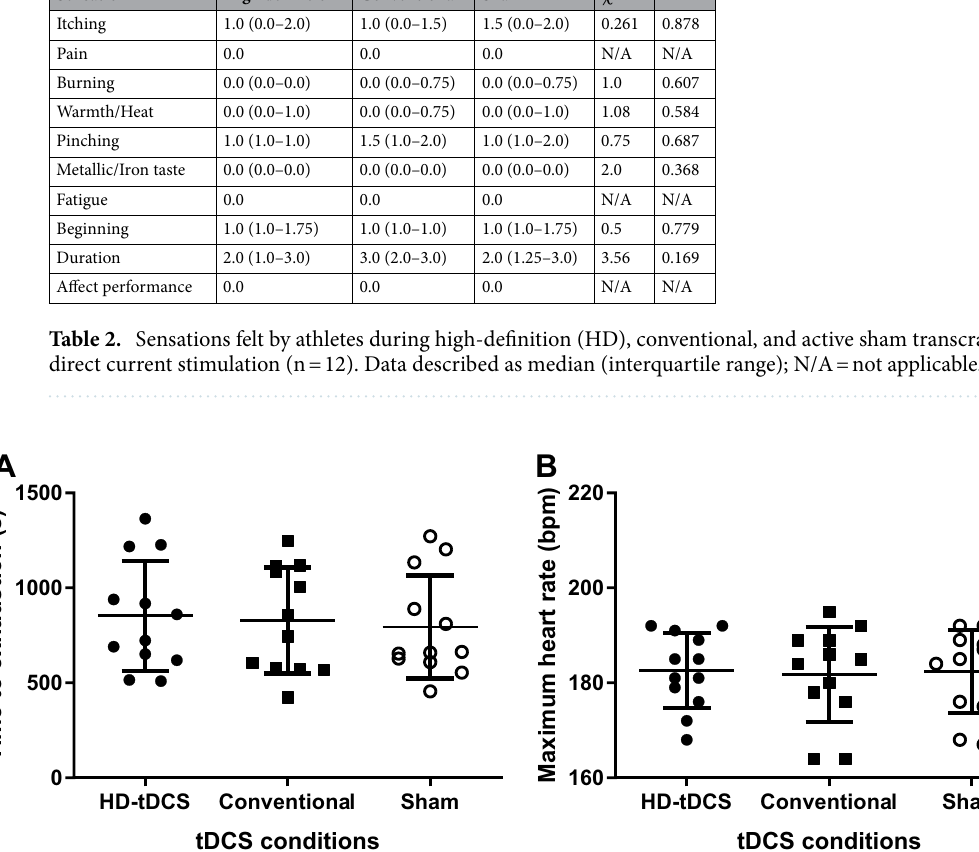
Figure 5. Effect of anodal high-definition, conventional, and sham tDCS on the time to exhaustion ( A ) and maximum heart rate ( B ) in time to exhaustion test with a constant load at 80% of peak power in athletes (n = 12). The data is presented as the mean, standard deviation, and individual data